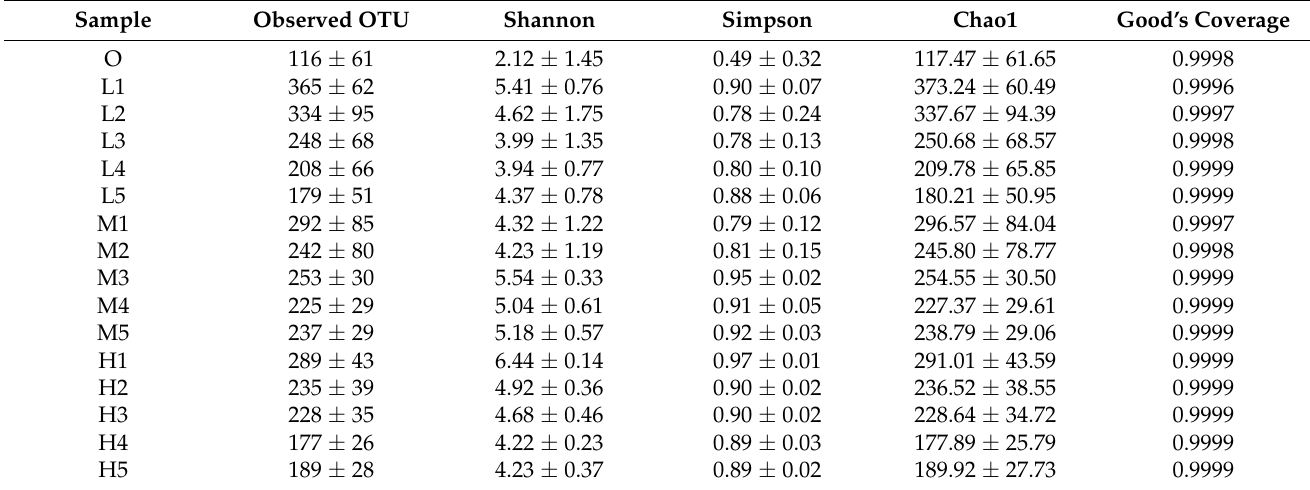
Table 1. Diversity indices of RTE meat samples †